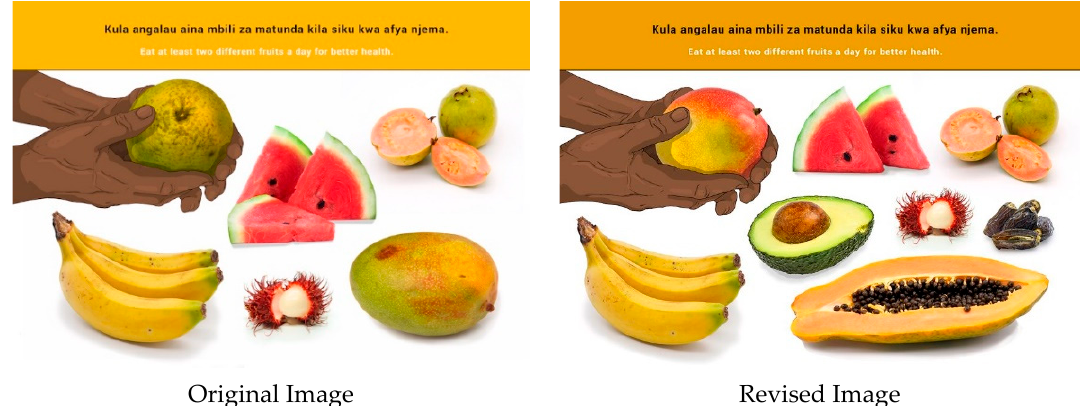
Figure 7. Eat at least two types of fruits every day for better health.